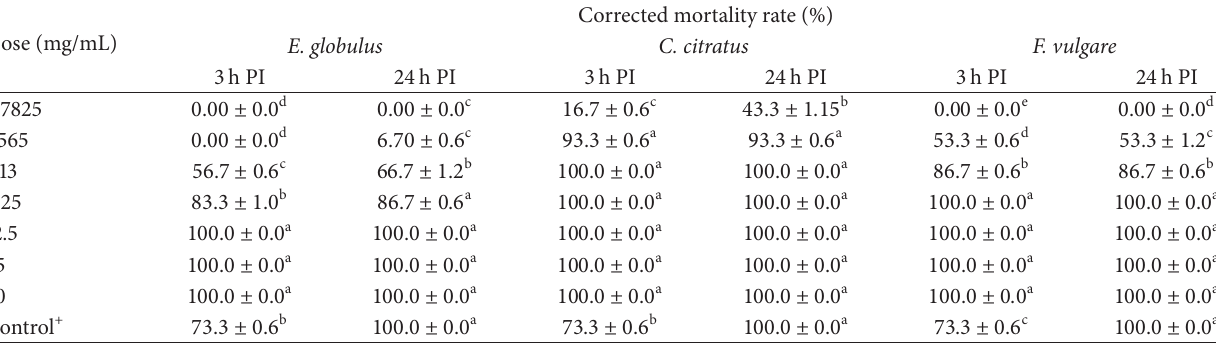
Table 1: The corrected mortalities of M. ovinus sheep keds exposed to different concentrations of C. citratus , F. vulgare , and E. globulus essential oils from the